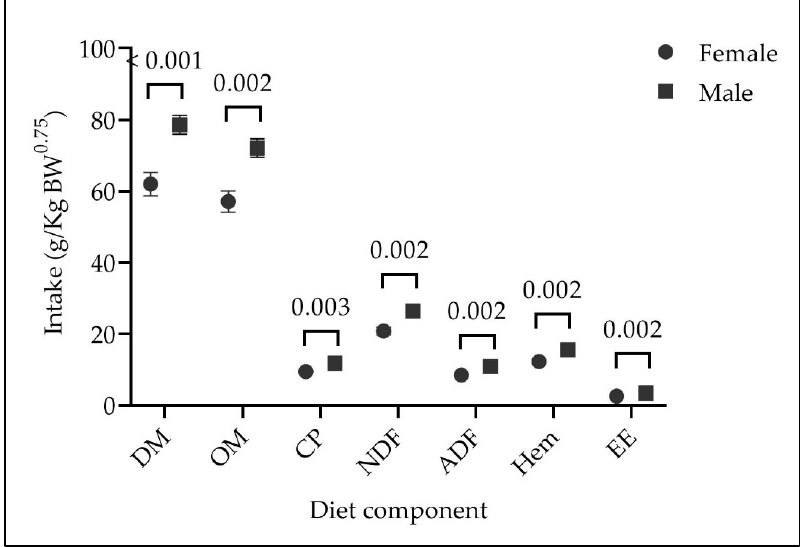
Figure 3. Difference in the daily dry matter (DM), organic matter (OM), crude protein (CP), neutral detergent fibre (NDF), acid detergent fibre (ADF), hemicellulose (Hem) and ether extract (EE) intake between females and males fed unflavoured diet (control) or diet flavoured with sucram, capsicum or both expressed as the mean ± standard error.